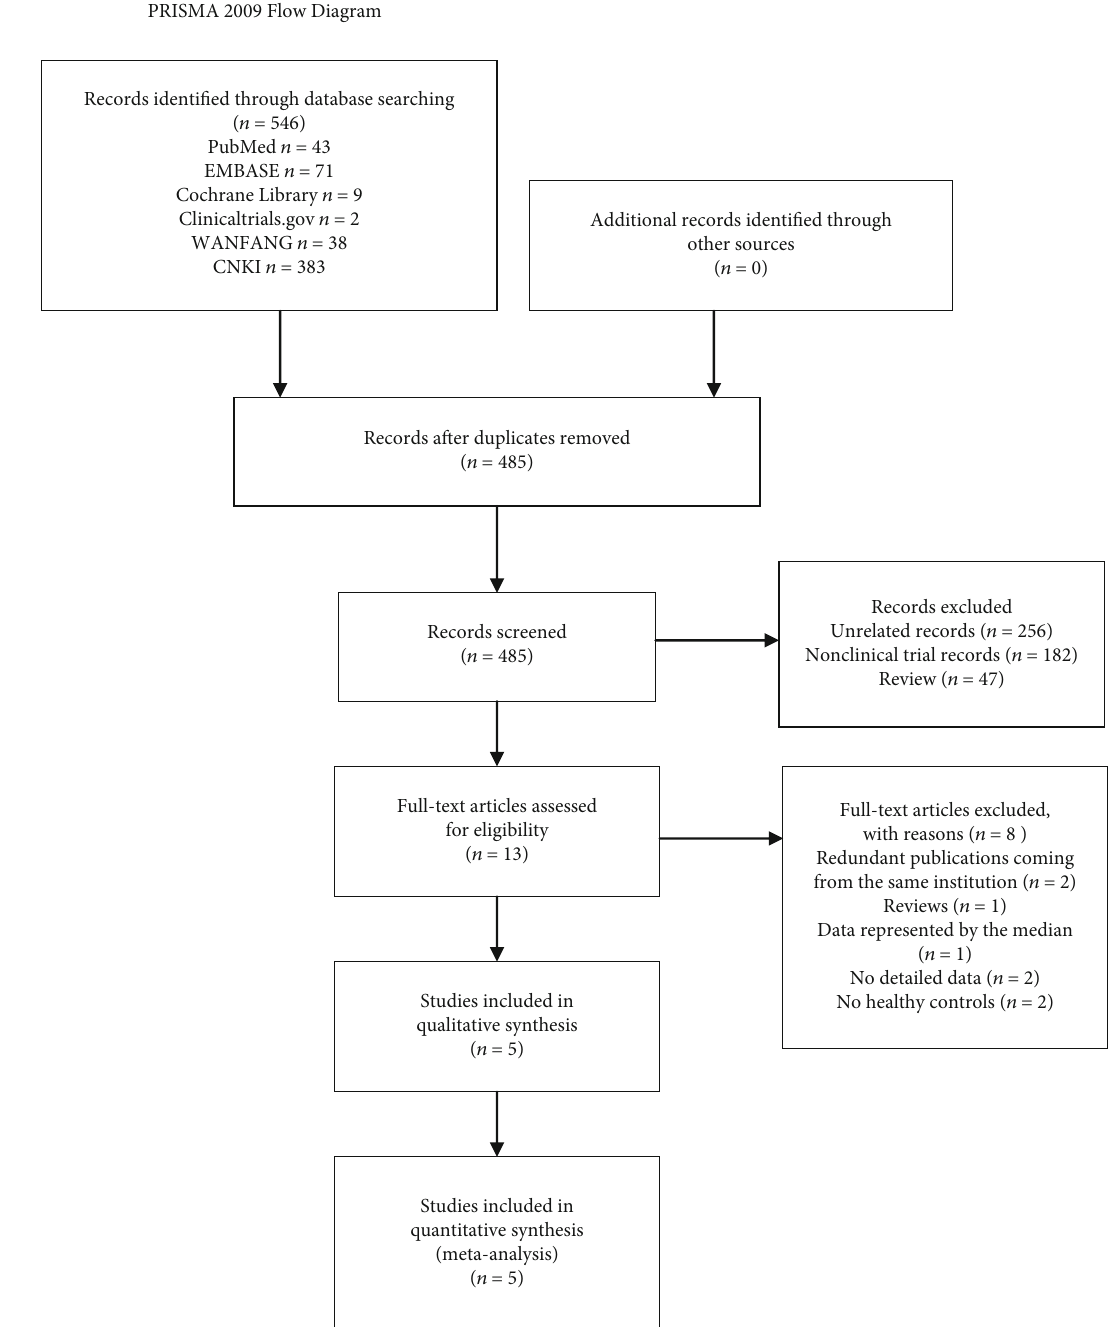
Figure 1: Flowchart of study inclusions and